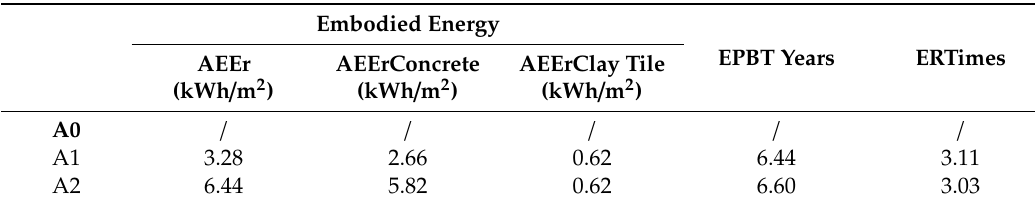
Table 5. Embodied energy, AEEr, EPBT and